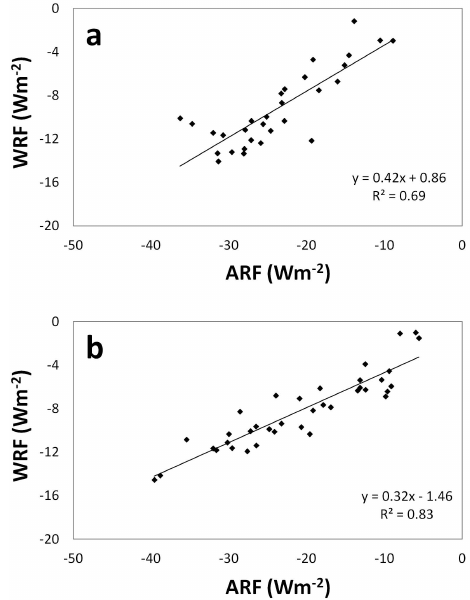
Fig. 13. Relationship between diurnal aerosol (ARF, x-axis) and water vapor (WRF, y-axis) radiative forcing over (a) Jaipur and (b) Chitkara, indicating moderate-strong association between the two forcings in Northwestern